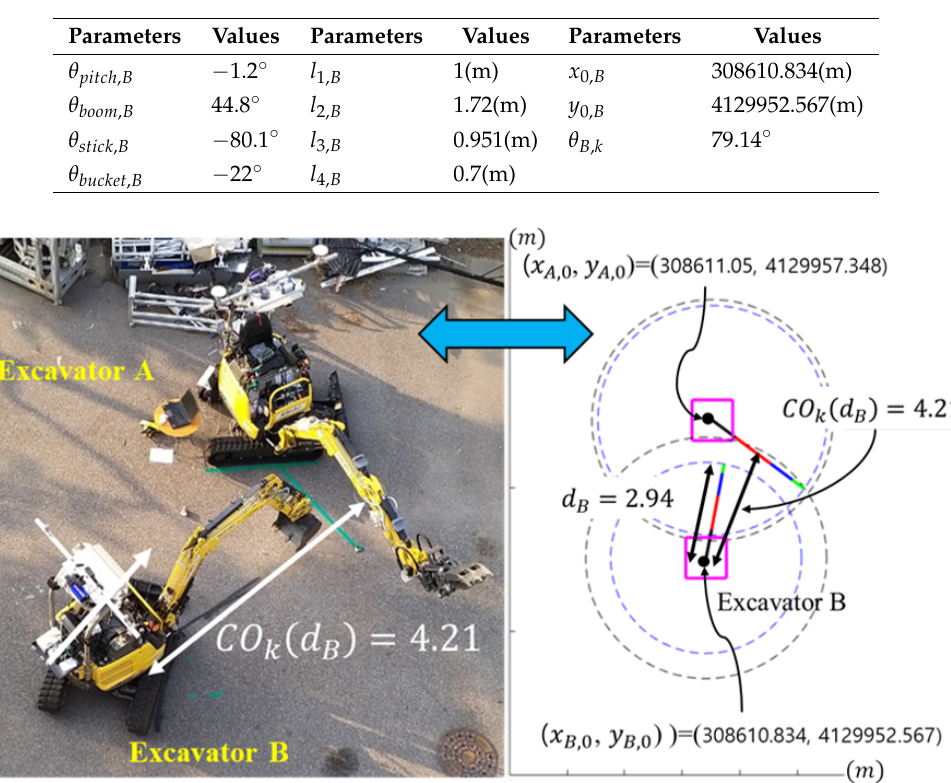
Table 6. Measured Posture Parameters: When B is closer to A.